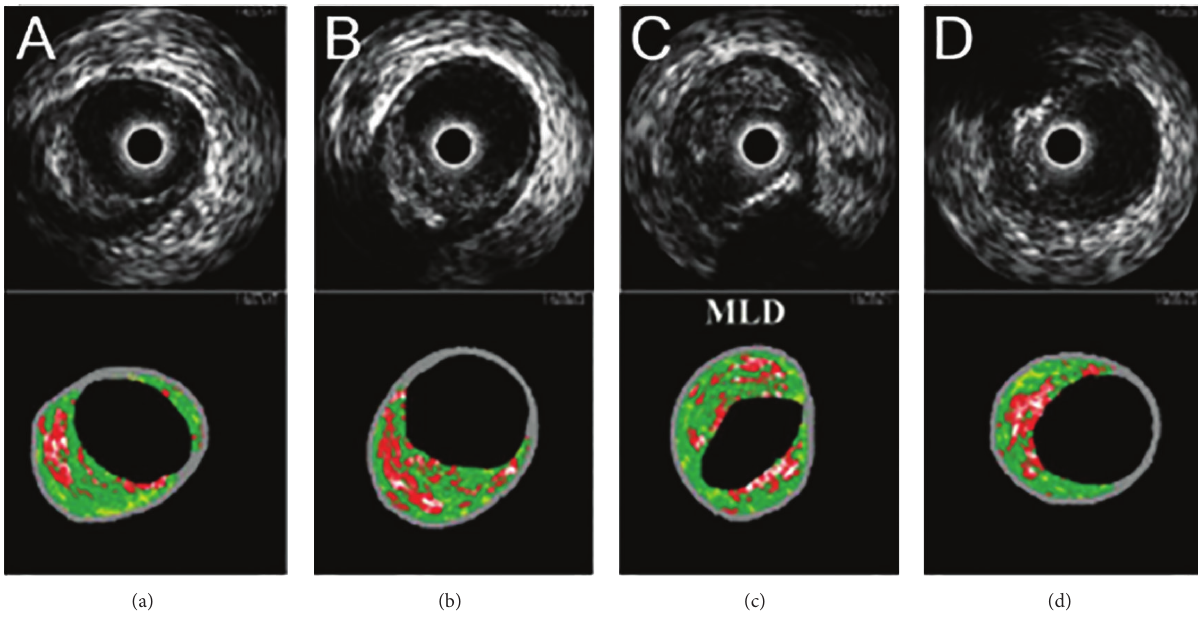
Figure5:Fourcross-sectionalimagesfromproximaltodistalwithinthesamepatientcoronarylesionobtainedbyIVUSandVH.Intheupper panels we see grey-scale IVUS with reconstructed IVUS virtual histology in the lower panels. (a) A thick fibrous cap overlying a necrotic core. (b) A thick fibroma can be seen with the thick overlying fibrous cap containing small spots of necrotic core. (c) Minimal Lumen diameter site. (d) A thin-cap fibroatheroma can be seen. Reprinted with permission from Surmely et al.